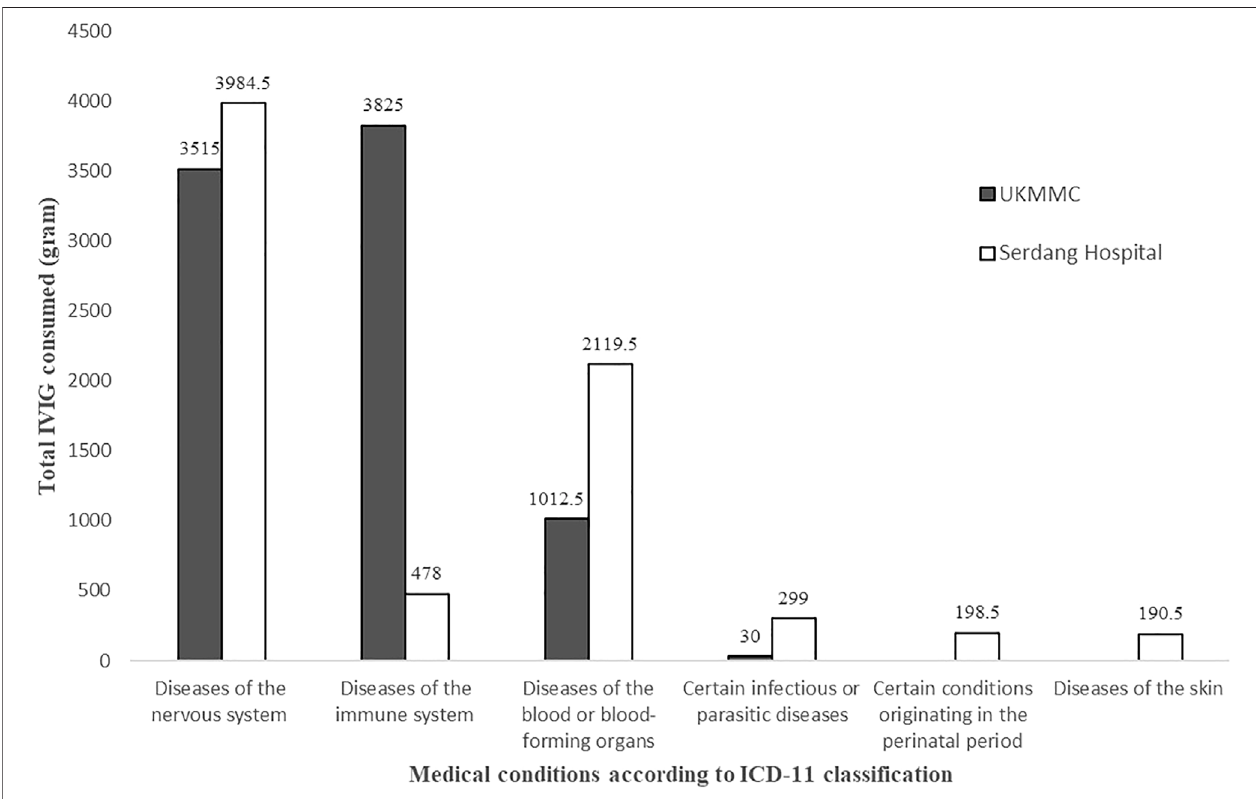
FIGURE 1 | Total IVIG consumed according to medical conditions as per International Classi fi cation of Diseases 11th Revision (ICD-11) for Mortality and Morbidity Statistics (Version: 05/2021) classi fi cation.